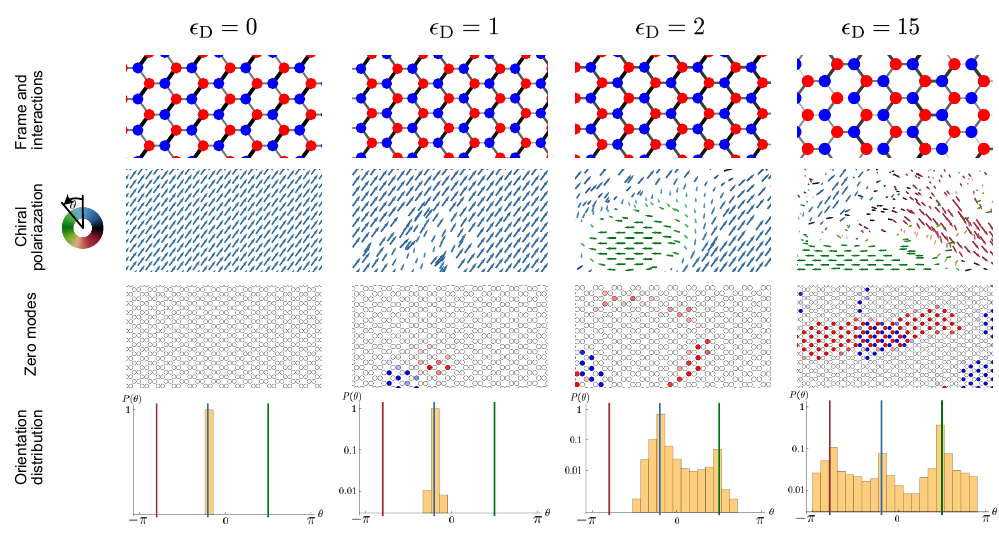
Figure 7: Topological zero-energy states in the bulk of disordered chiral insu- lators First row Sketch of the honeycomb frame and of the coupling strengths for increasing spectral disorder. The strengths of the couplings are represented by the width of the dark lines. Their randomness is quantified by the variance of the Gaus- sian couplings ε . The correlation length for all the examples is ξ = 12 a . Second D row Corresponding chiral polarization fields. The color indicates the orientation θ of Π ( x ) . Third Row: Magnitude of the zero-energy modes on the A (red) and B (blue) sites. Fourth row: Probability density function of the orientation θ . Remarkably, even in the disordered cases, the distribution peaks only at values characteristic of the three phases of the homogeneous chiral